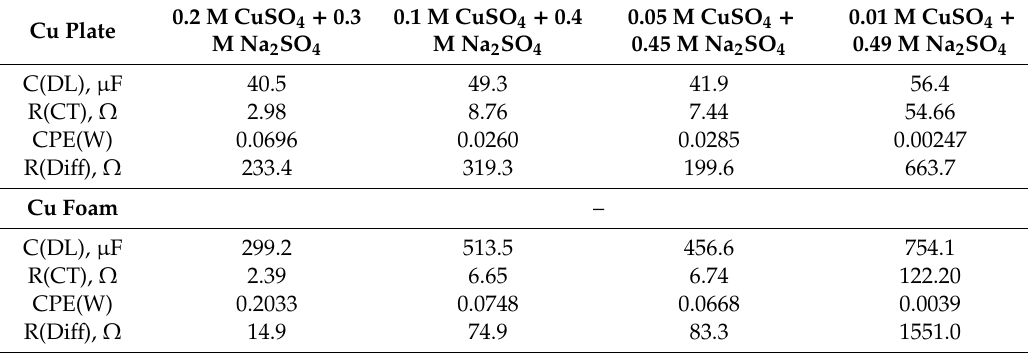
Figure 6. Dependence of di ff usion-related elements of EEC on the potential applied. Measurements performed using a copper plate and copper foam as working electrodes in 0.1 M CuSO 4 + 0.4 M Na 2 SO 4 solution. Table 3. Values of electrochemical impedance spectroscopy (EIS) parameters obtained by fitting data obtained on copper foam and copper plates at − 0.175 V versus Ag / AgCl at di ff erent copper concentrations. EC used for modeling shown in Figure 3 inset. CPE(DL): a double-layer (DL) capacitance modeled via the constant phase element (CPE), CPE(W): the capacitance caused by the concentration gradient, R(CT): charge transfer resistance, R(Di ff ): resistance caused by the concentration gradient.